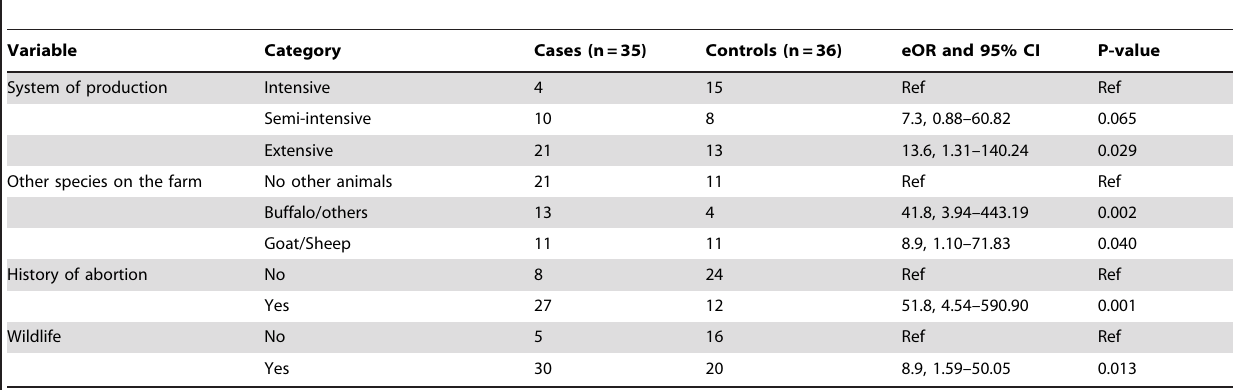
Table 2. Multivariable logistic regression of potential risk factors for bovine brucellosis herd seropositivity in Peninsular Malaysia.